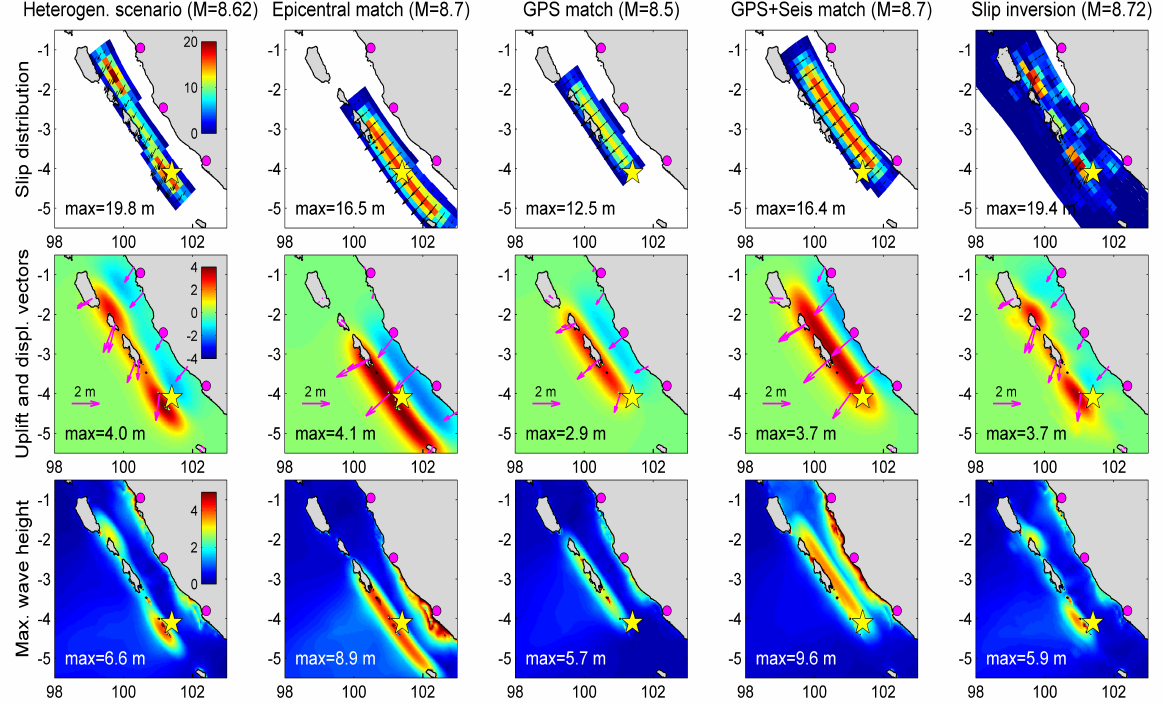
Fig. 5. Comparing different methods of source inversion for a synthetic scenario with strongly heterogeneous slip distribution. Rows: First: slip distribution (color) and rake angle (arrows), epicenter (yellow star) and tide gauge positions (magenta circles, from north: Padang, Muko Muko, Bengkulu). Second: sea floor deformation and horizontal GPS displacement vectors. Third: maximum wave height. Columns: First: synthetic scenario with heterogeneous slip distribution (forward model). Second: scenario match from a pre-computed databank based on seismic data only (epicenter and magnitude). Third: best matching scenario using GPS. Fourth: best match using GPS plus seismic magnitude. Fifth: direct inversion of GPS into slip distribution.